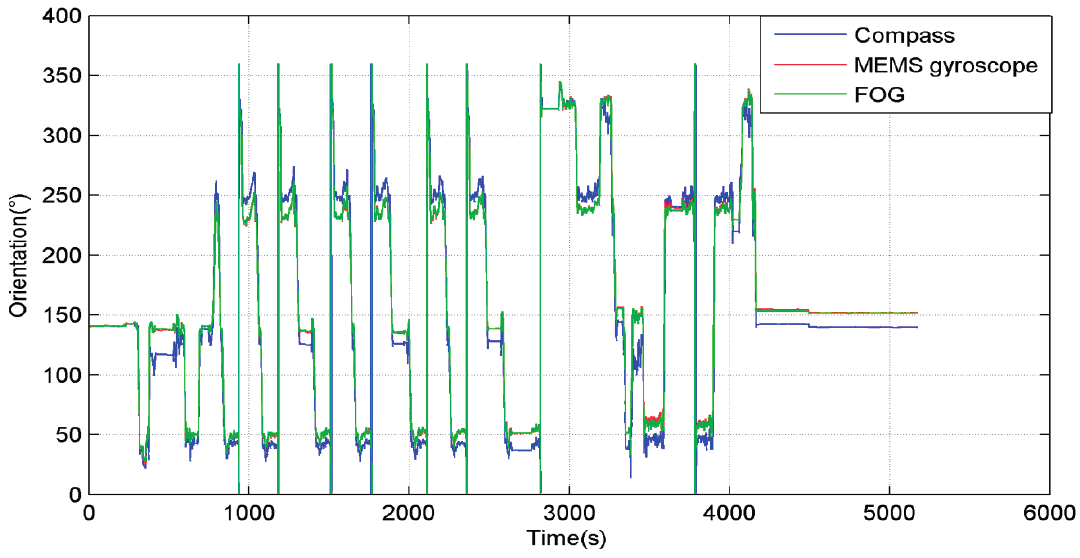
Figure 8. Orientation in the entire process.